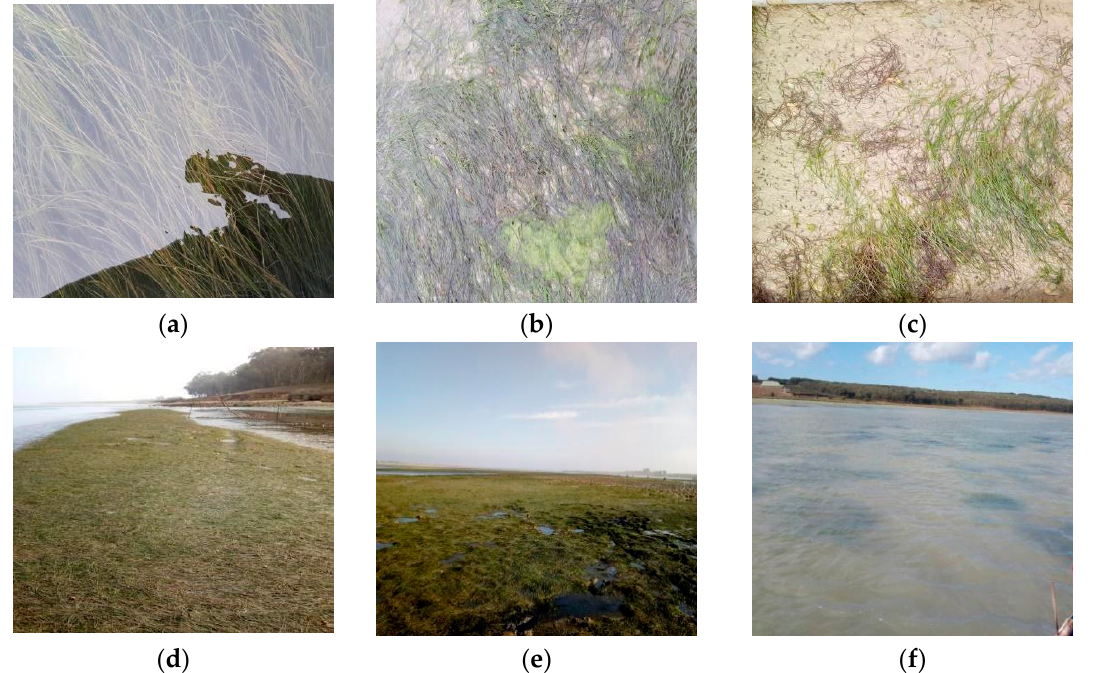
Figure 4. Quadrats of Z. noltei in the homogeneous station ( a ) S3 and in mixed stations ( b ) S5 (dense) and ( c ) S7 (sparse, submerged), their respective bed photography ( d – f ) .